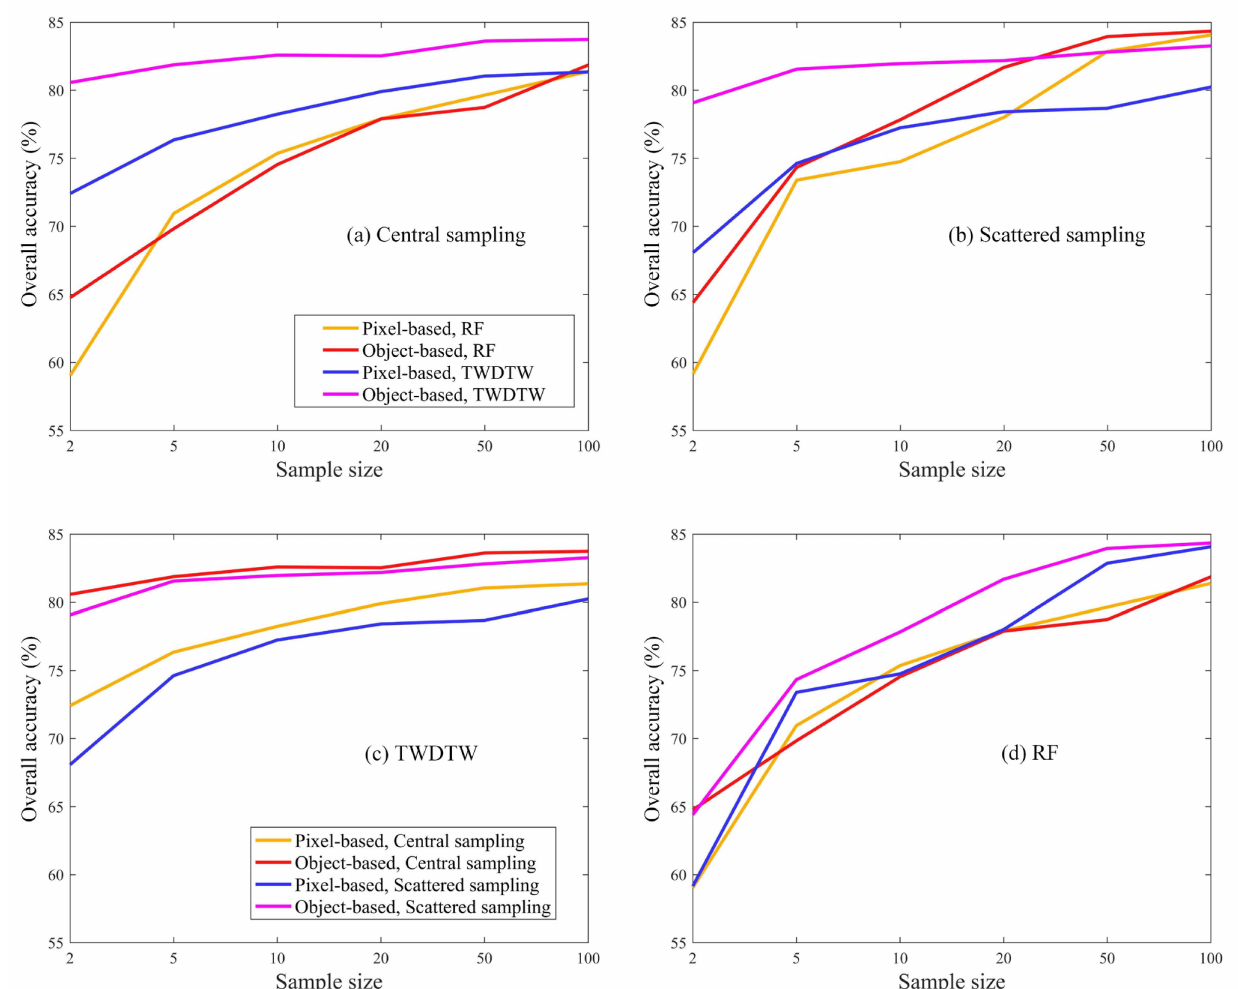
Figure 11. Accuracy sensitivities of different classification strategies to sample size. RF and TWDTW are the abbreviations of Random Forest and Time-Weighted Dynamic Time Warping,